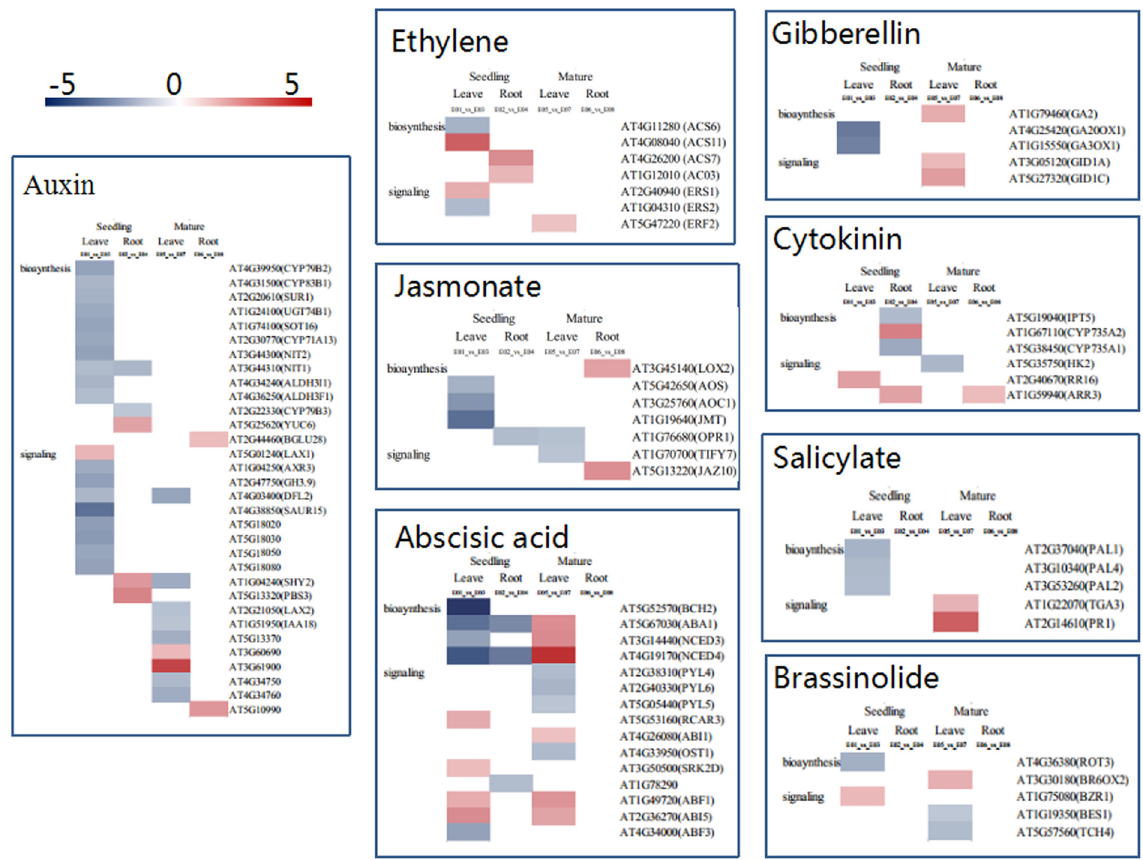
Fig 8. Representative gene expression profiles of hormone biosynthesis and signaling pathways in leaves and roots at seedling and mature stages. Only DEGs are shown in the heat map. Each color spot reflects the expression of a corresponding gene. Red indicates the upregulation of gene expression, blue represents the genes were downregulated, and white indicates that no signal was detected at RNA level.